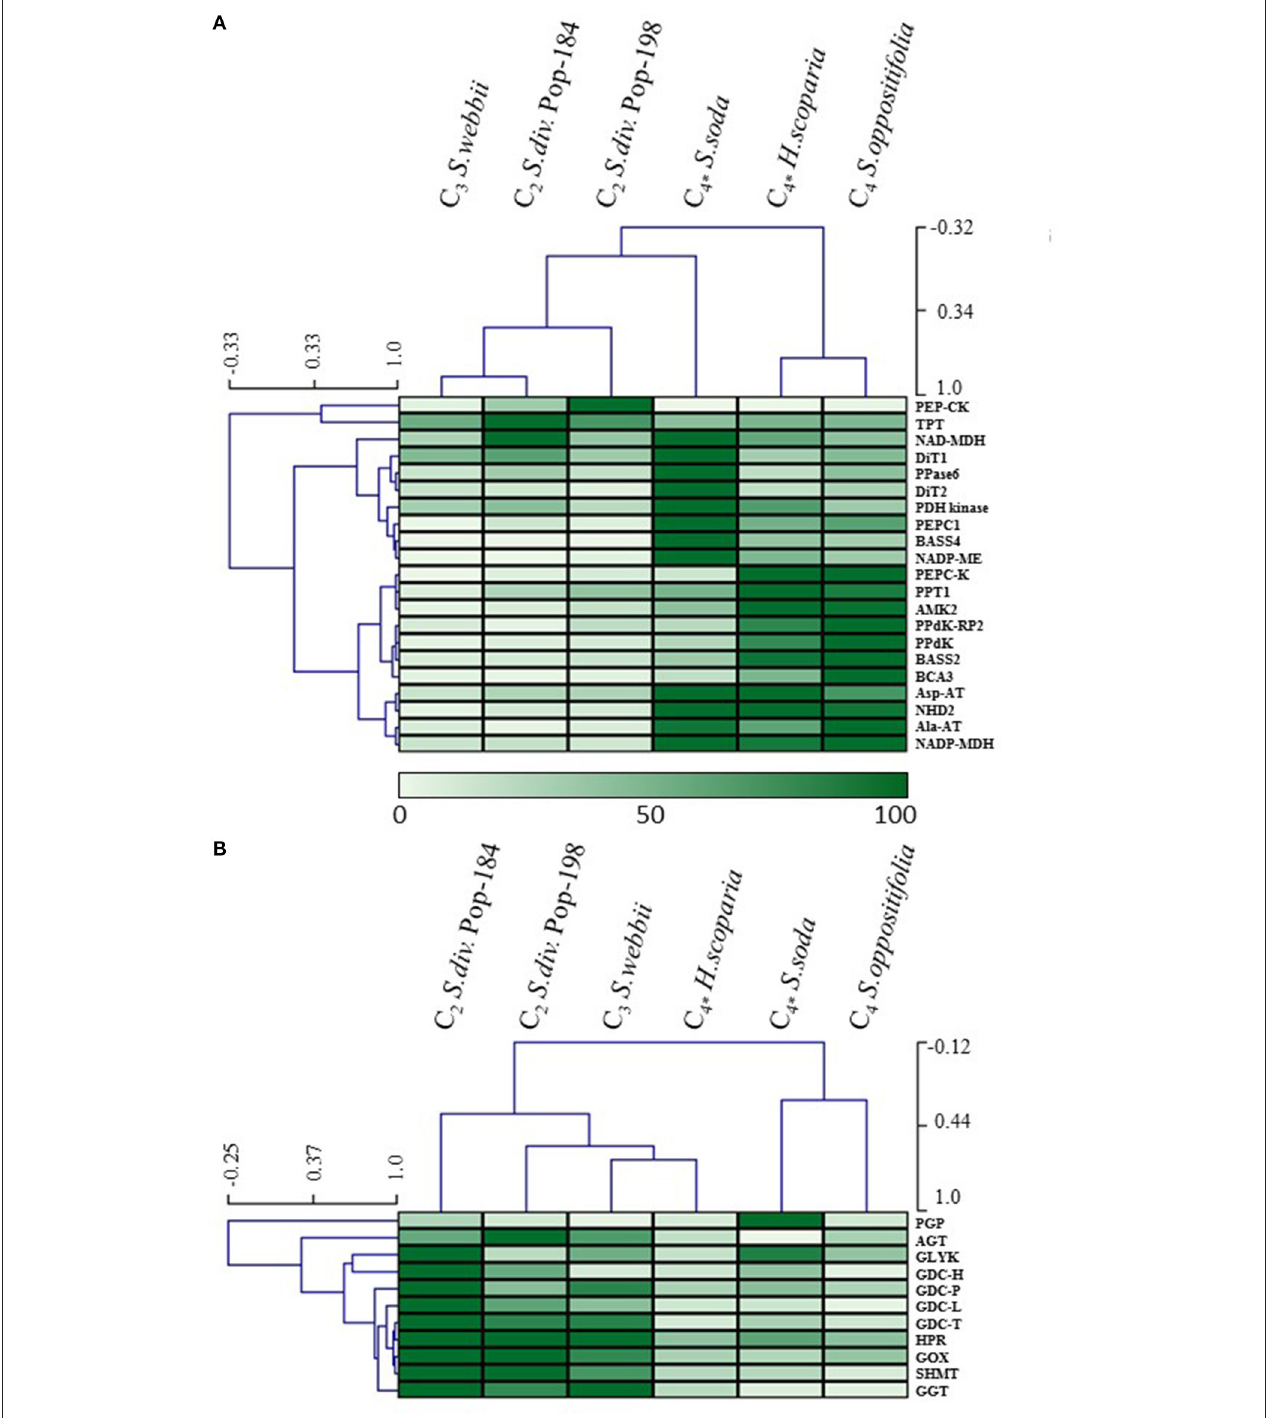
FIGURE 3 | Hierarchical clustering and heatmap of relative transcript abundance of genes encoding (A) known C 4 cycle proteins and (B) the eight core enzymes of photorespiration (C 4* , species with C 4 photosynthesis in leaves/assimilation shoots but C 3 in cotyledons; S. div , S. divaricata ; for description of abbreviated genes see text).